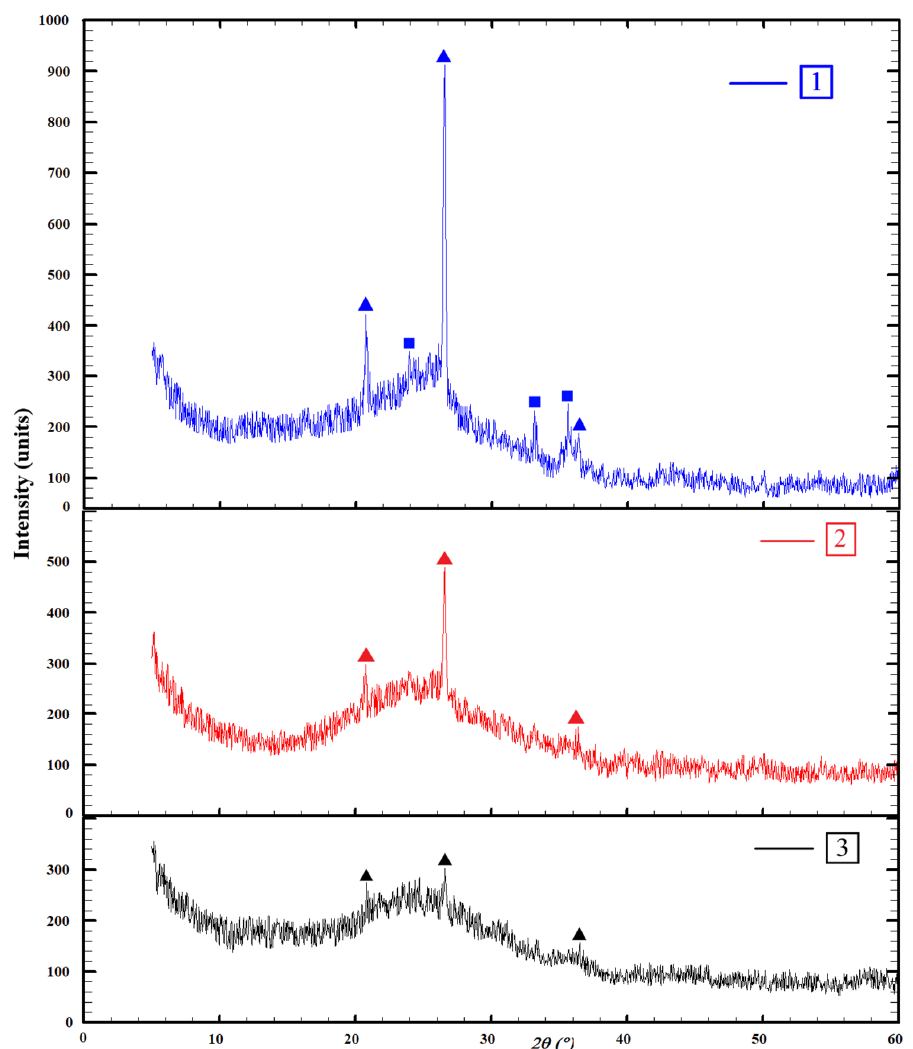
Figure 3. Results of X-ray analysis of coal energy waste: 1—ASM; 2—fly ash; 3—slag; Δ—high quartz (SiO 2 ), □—hematite (Fe 2 O 3 ).